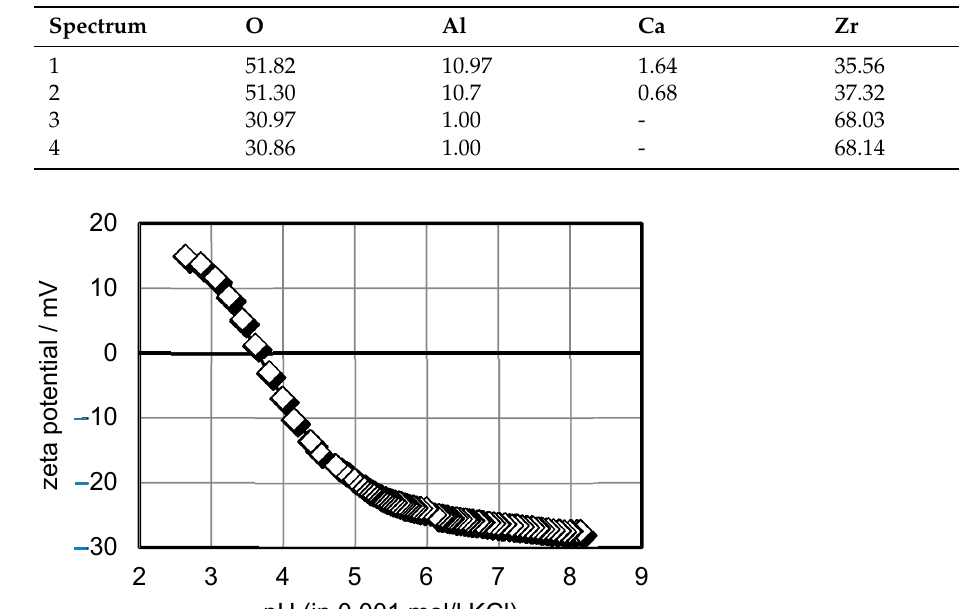
Figure 7. Flux dependent on time for the NF membrane.